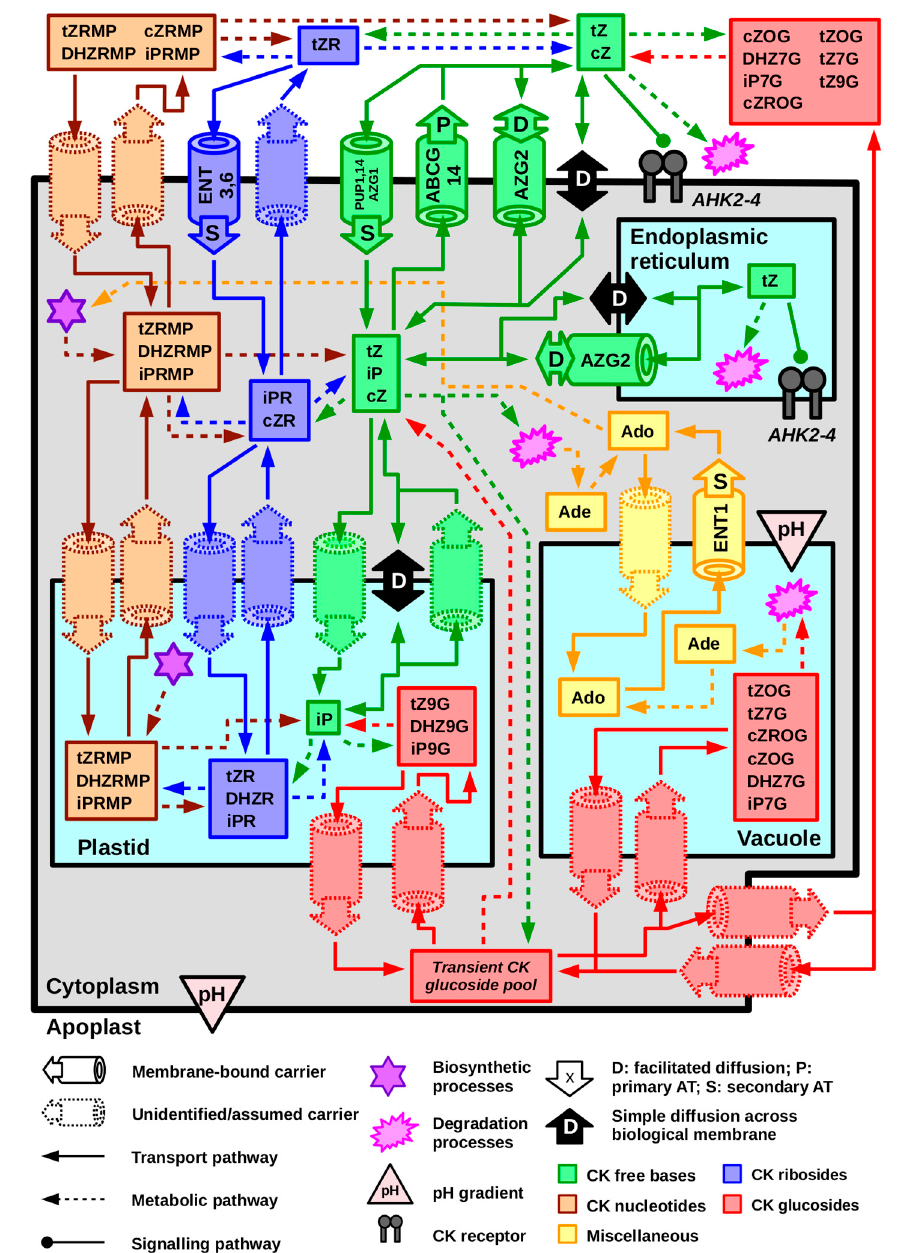
Figure 4. A proposition of a comprehensive scheme of cytokinin (CK) cellular homeostasis in Arabidopsis based on the current knowledge of cytokinin cellular trafficking in vascular plants. The plant cell is reduced to a simplified model depicting a plastid, a vacuole, endoplasmic reticulum, cytoplasm, and apoplast. Free CK bases, ribosides, nucleotides, and glucosides are grouped into their respective pools. Labels within the pools mark CK species that have been found in the given compartment in a significant amount [70,77]. Membrane-bound carriers with known subcellular localization are depicted together with a symbol indicating which kind of membrane transport process they mediate. Note that in case of free bases, which might be considered more hydrophobic than other CK species (refer to Figure 2), simple diffusion across the membrane is considered as well. Several putative membrane-bound carriers have been added to show possible transport routes that haven’t been characterized or addressed yet. However, it is not implied that all of them have to be actually involved in CK trafficking. Light pink triangles indicate pH gradient, with the point located on the more acidic side of the